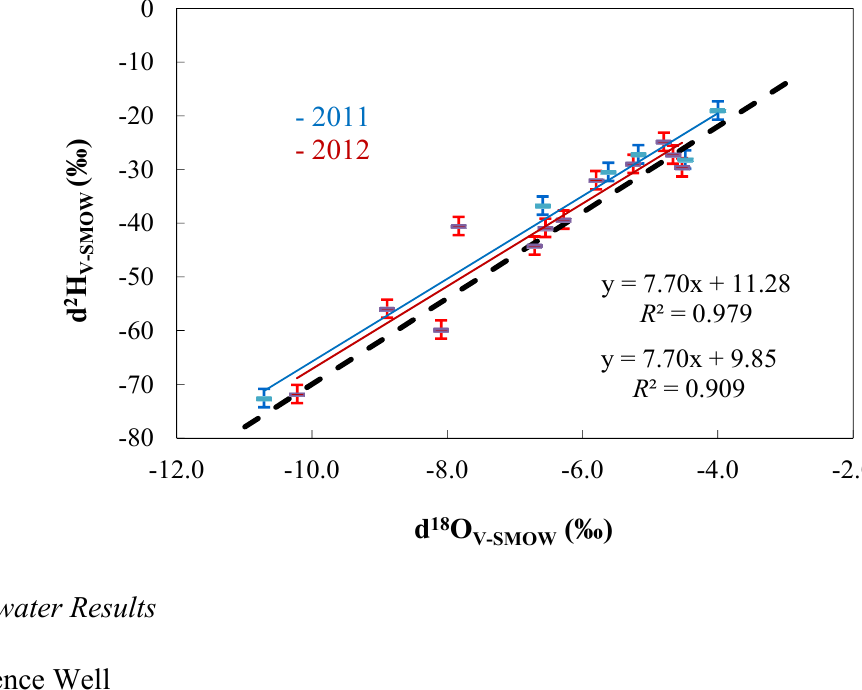
Figure 3. Relationship between the δ 18 O and δ 2 H rainfall values for 2011 and 2012 compared to the GMWL line (dotted